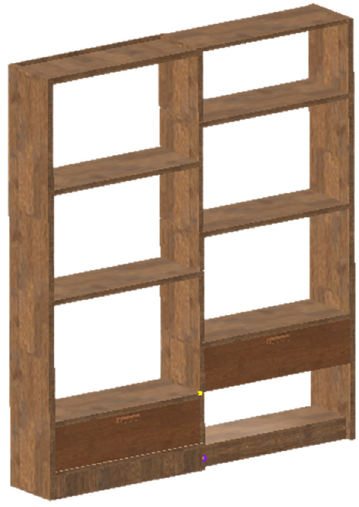
Figure 2. Finished product of the case study.